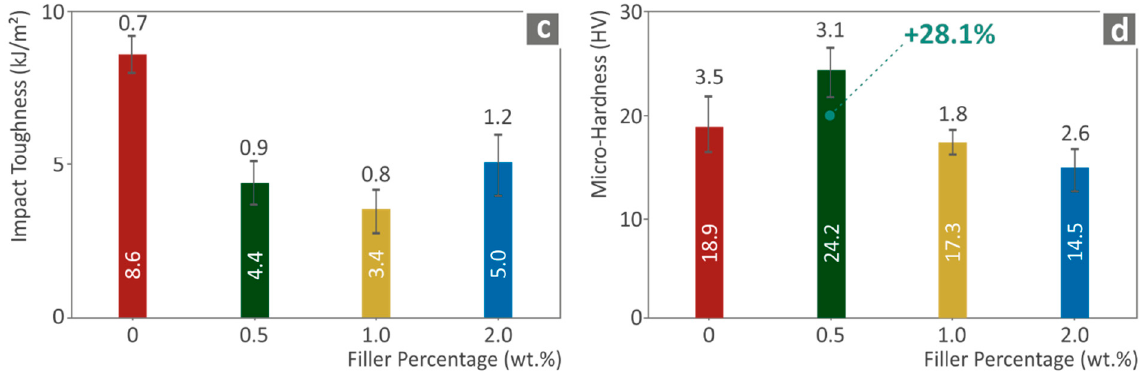
Figure 3. ( a ) Average tensile toughness (MJ/m 3 ) to filler loading (wt.%), ( b ) Average flexural toughness (MJ/m 3 ) to filler ratios (wt.%), ( c ) Charpy’s notched impact toughness (kJ/m 2 ) to filler loadings (wt.%), ( d ) Vickers microhardness (HV) to filler ratios (wt.%).